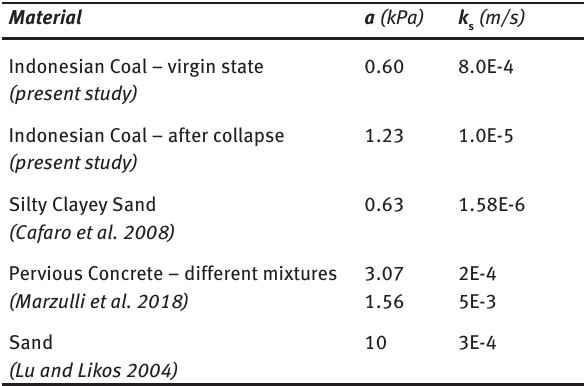
Table 8: Hydraulic properties of the Indonesian coal in comparison to other granular materials